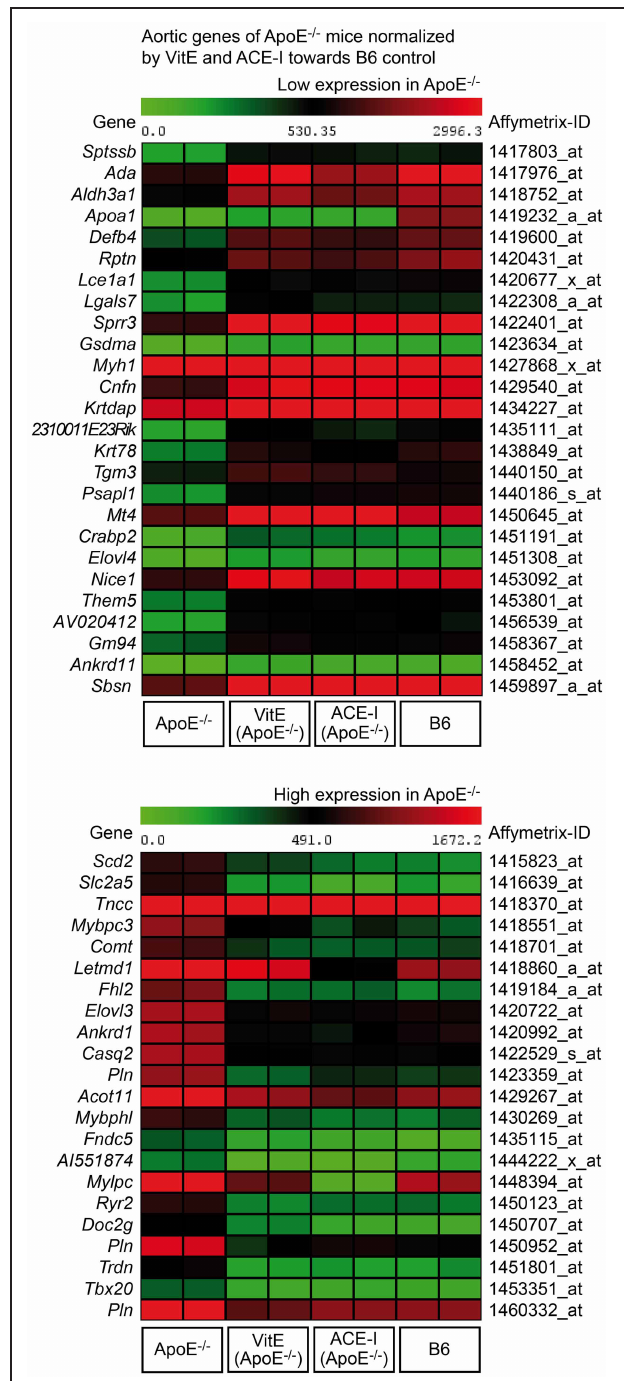
FIGURE 3 | Identification of atherosclerosis-related aortic genes of untreated ApoE − / − mice, which were normalized by vitamin E (VitE) and ACE inhibitor (ACE-I) treatment toward B6 control level. The first panel presents a heat map of genes with low expression in untreated ApoE − / − aortas, and the second panel presents probe sets with high expression in untreated ApoE − / − mice ( P ≤ 0 . 01, and ≥ 2-fold, or ≤− 2-fold